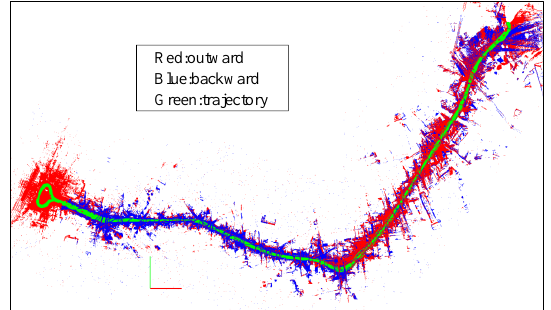
Figure 6. DMPs and evaluated positions